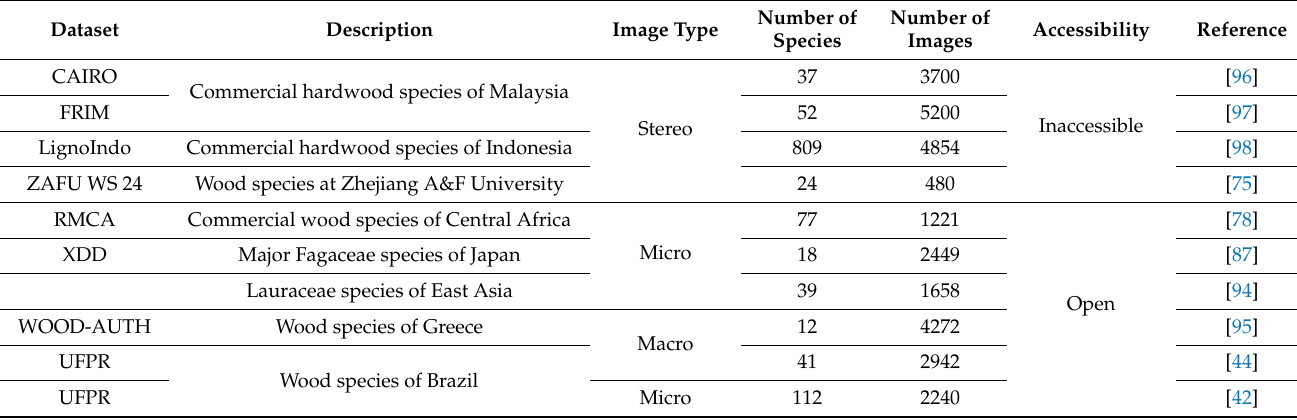
Table 2. Wood image datasets available for computer vision-based wood identification research, adapted from